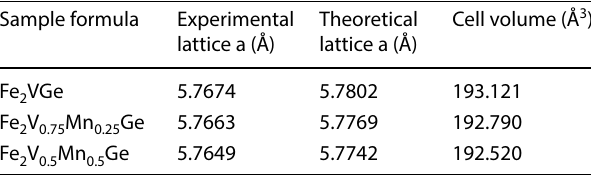
Fig. 2 In ( a ), the variation of concentration-dependent in-plane lattice parameters and concentration-dependent cell volume vari- ation in ( b ) Table 1 The variation of concentration-dependent, lattice param- eters, and the unit cell volume Sample